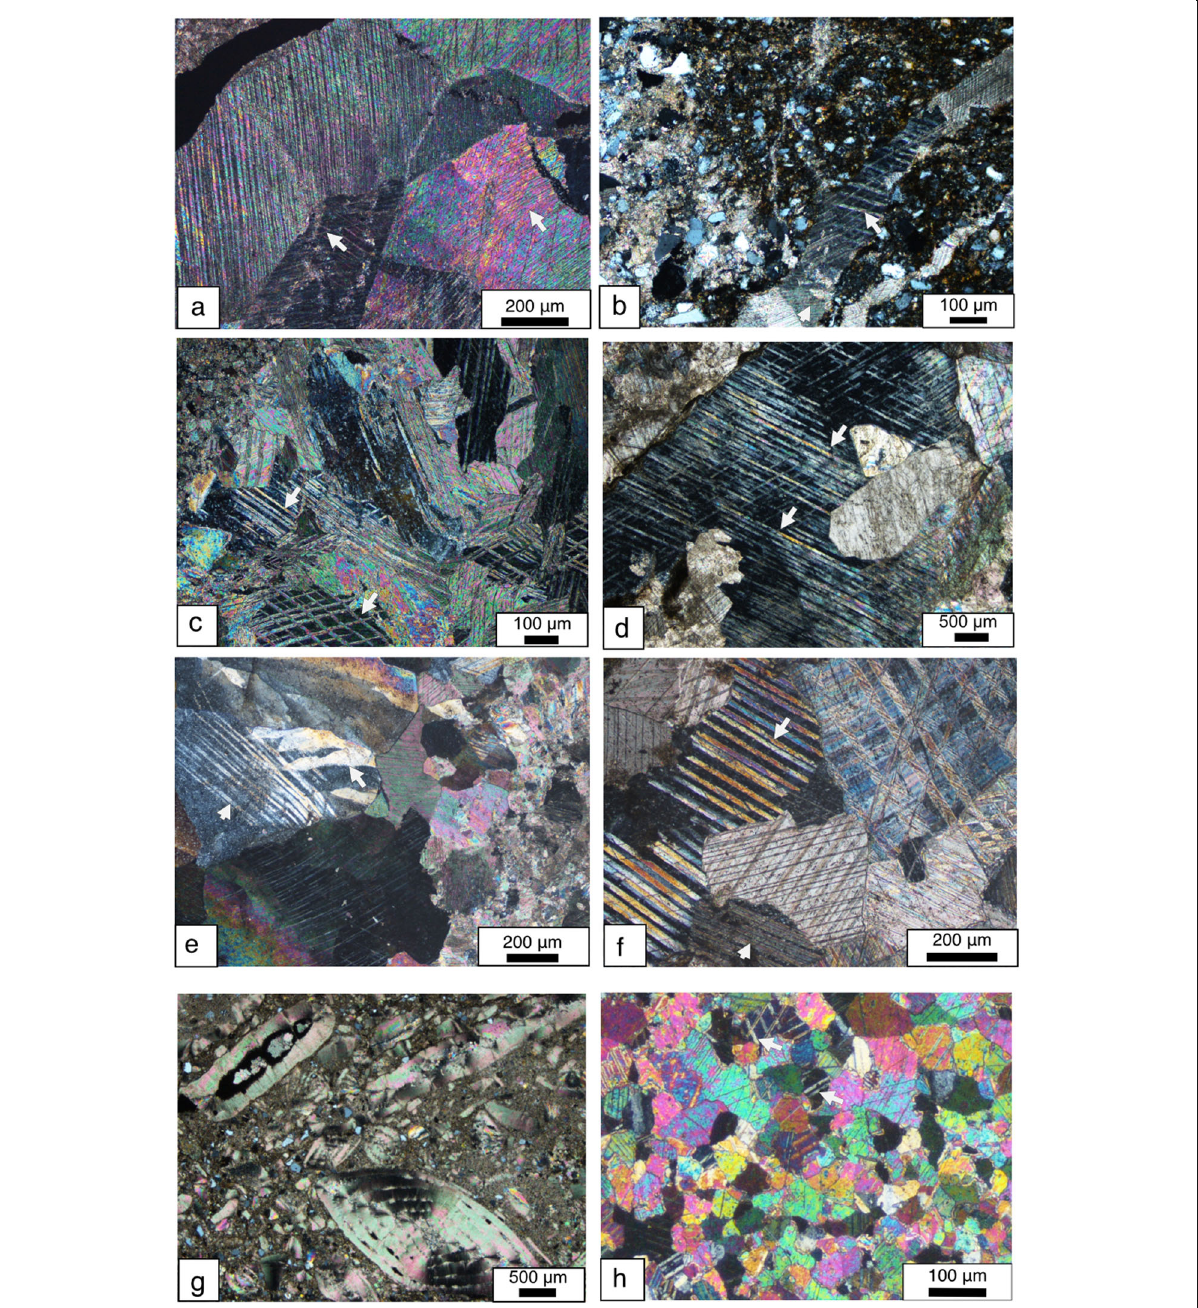
Fig. 3 a Type-I deformation twins (arrows) have predominantly developed within calcites veins from the gouge of NT (PJ5), implying a temperature of less than 170 °C (Ferrill et al. 2004). b Limited development of type-I and type-II twins in the calcite veins of PWN1. c Predominance of type-II twins in the calcite veins of CM2. d Predominance of type-II twins in the calcite veins of KP1. e Type-II (short arrow) and type-III (long arrow) twins with few recrystallized calcite grains (small grains in the left side) occur within footwall calcite veins near MBT contact (GM6a). f Type-I deformation twins (short arrow) have predominantly developed in the older dilational calcite veins occurring in limestones (GM8a) in footwall of MBT. Few grains have developed type-II twins (long arrow). g Fossiliferous limestone sample CM1 showing foraminifera fossils with limited deformation twins. h Few twins (arrows) are developed in the fine-grained stromatolitic bodies occurring in the hanging wall of MBT